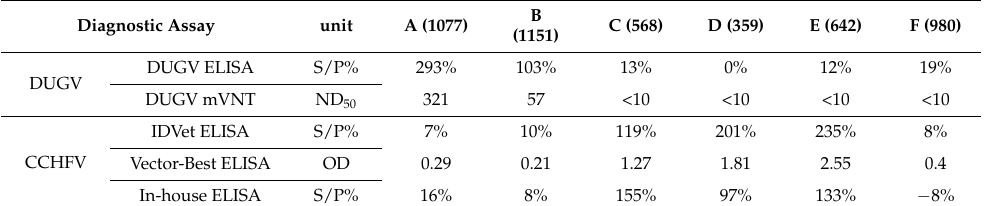
Table A1. Detailed version of Table 4 in the main section.